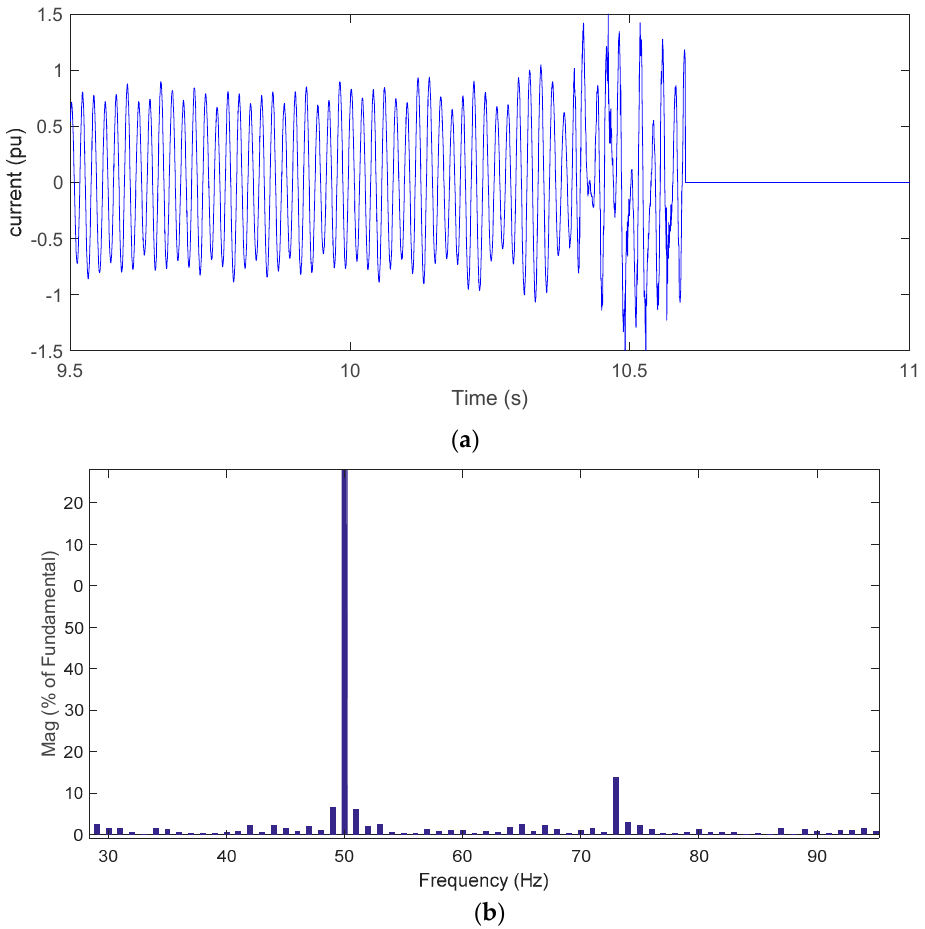
Figure 12. Time-domain simulation for SCR = 1.25, X g / R = 20 and X c / X g = 0 (an unstable case), ( a ) current, ( b ) fast Fourier transform (FFT) of the current before trip.